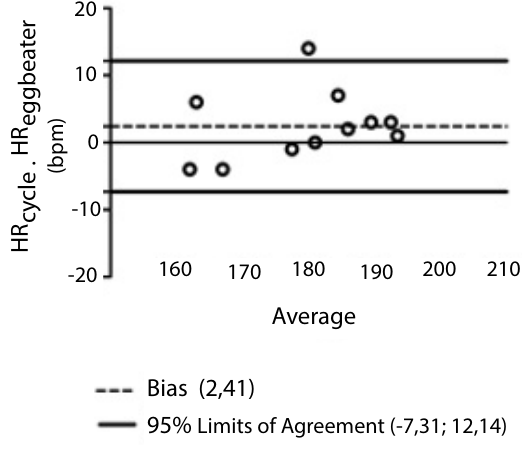
Figure 4: HR’s Bland–Altmann